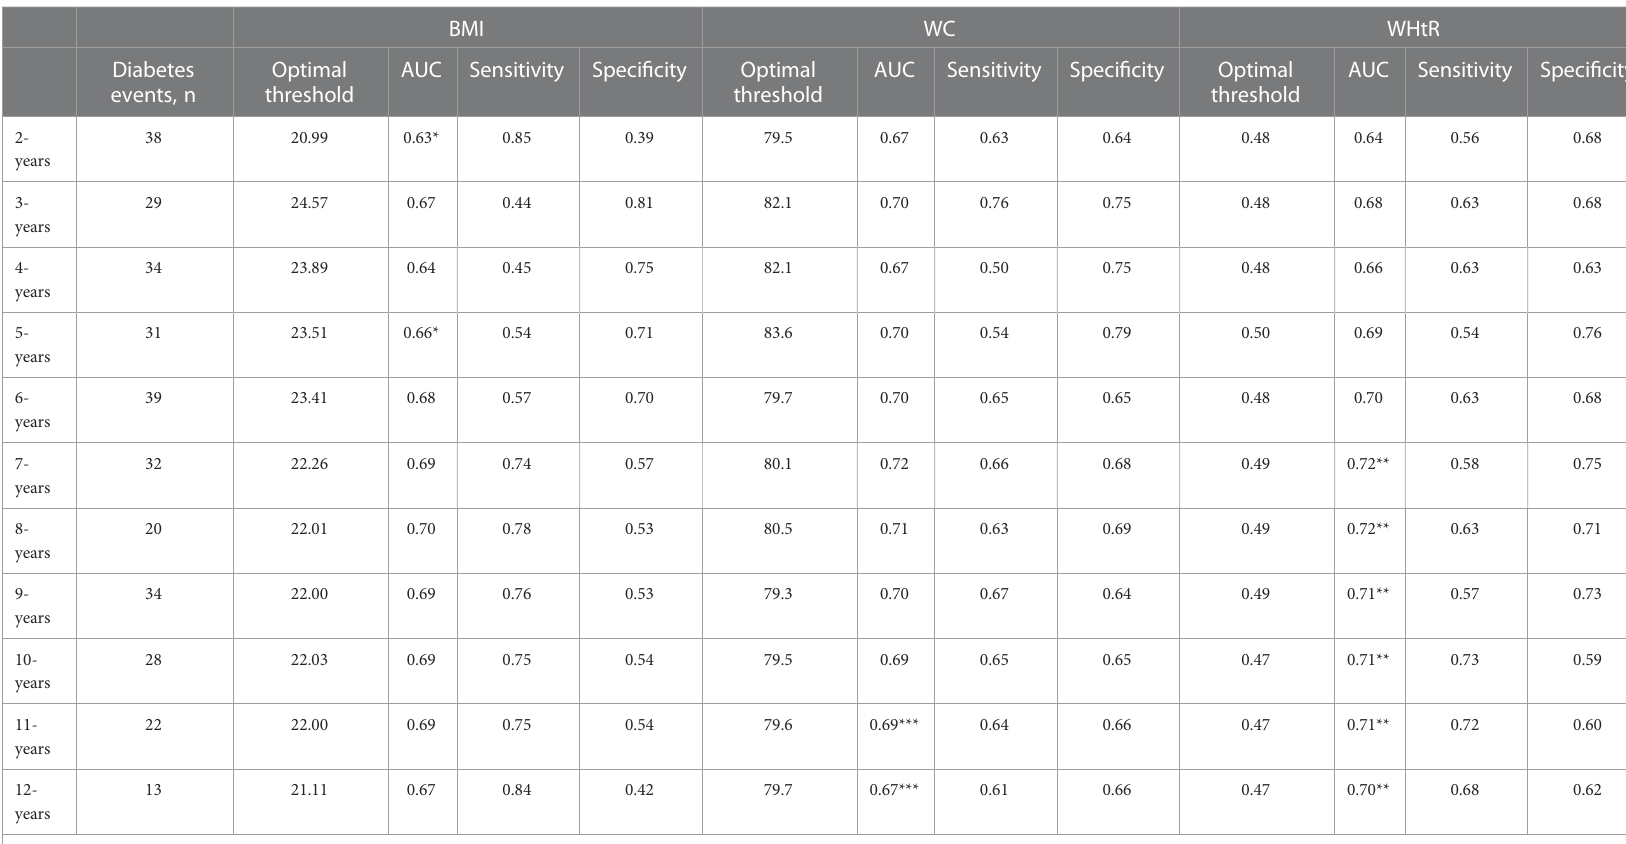
TABLE 3 Best threshold, sensitivities, speci fi cities and areas under the time-dependent receiver operating characteristic curves for BMI, WC and WHtR predicting future diabetes risk. BMI WC WHtR Diabetes Optimal AUC Sensitivity Speci fi city events, n threshold